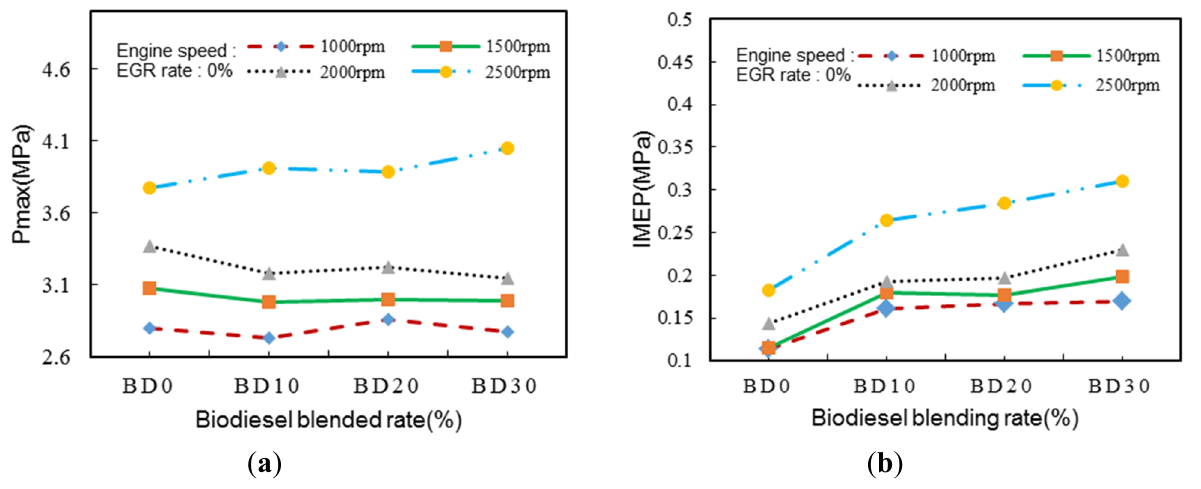
Figure 3. Effects of the engine speed and biodiesel blend ratio on the ( a ) peak combustion pressure and ( b ) indicated mean effective pressure